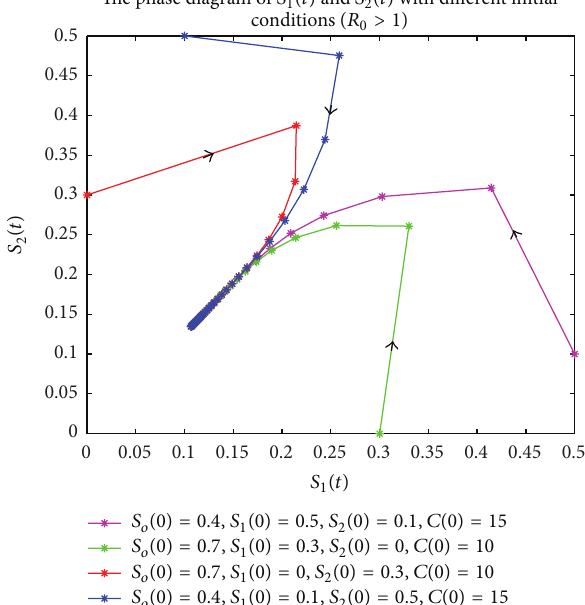
Figure 3: The phase diagram of 𝑆 1 (𝑡) and 𝑆 2 (𝑡) with 𝑘 1 = 5 and = 6 . This gives 𝑅 ≈ 1.3180 < 1 and the coopetition makes the 𝑘 2 0 market share of the enterprise